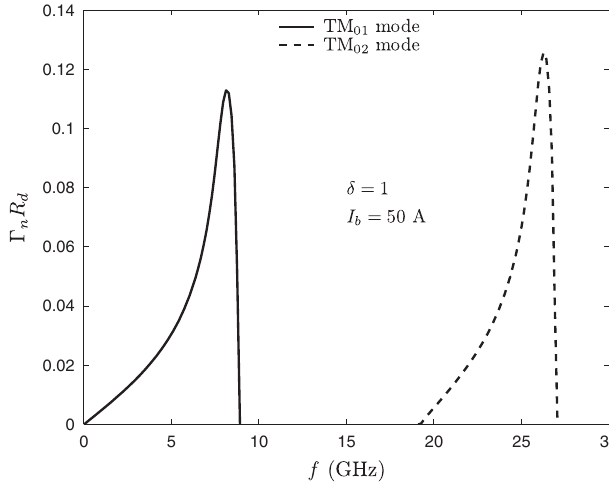
FIG. 5. Normalized spatial growth rates for TM 01 and TM 02 modes for a 50 A beam with (cid:1) ¼ 1 .